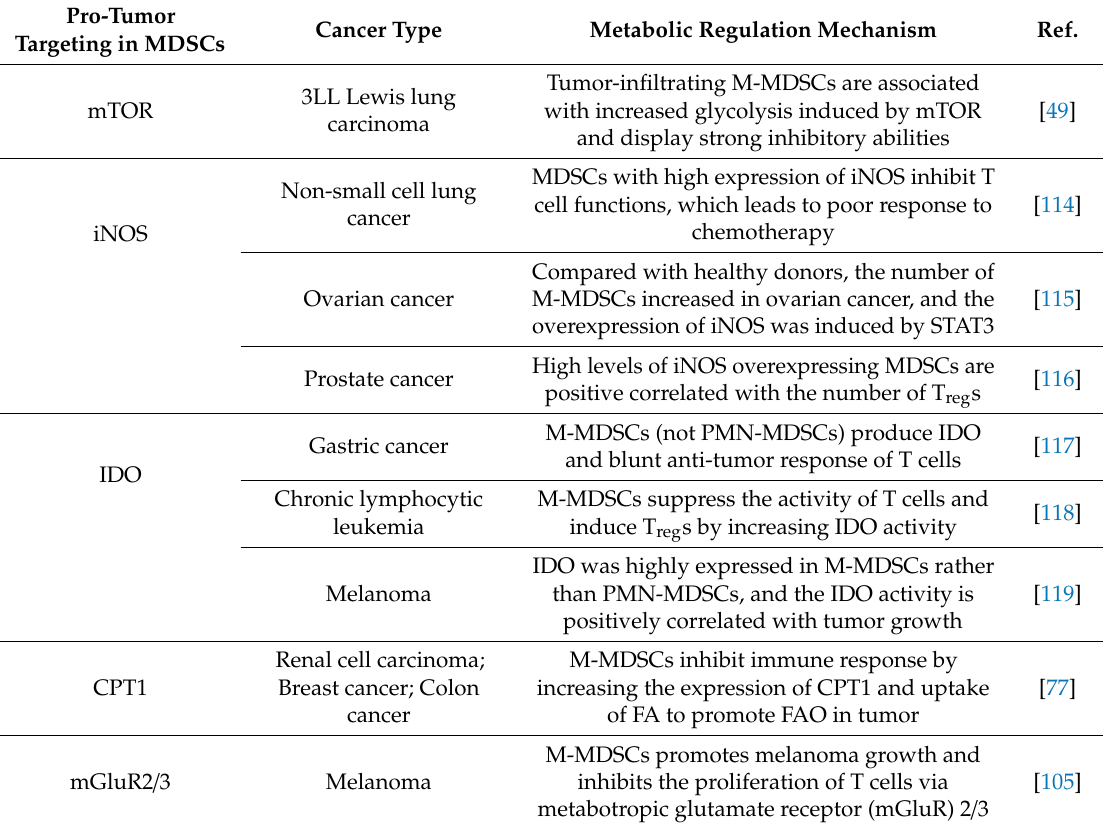
Table 4. M-MDSCs in